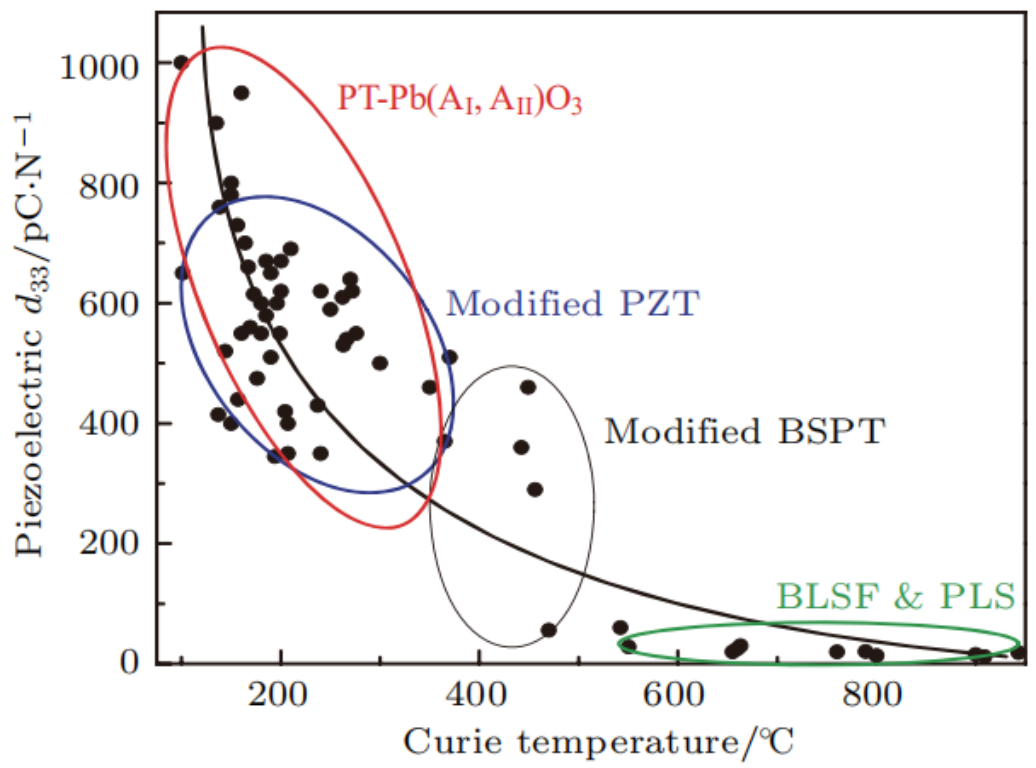
Figure 4. Piezoelectric coefficients and Curie temperature of common piezoelectric ceramics rel- ative to components. Reproduced with permission from Ref [133]. Copyright 2010 American Chemical